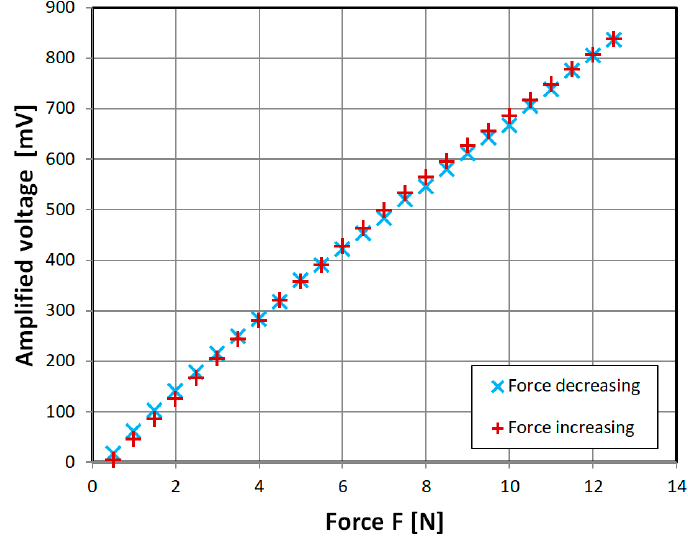
Figure 13. Obtained experimental characteristic of developed ‘diagonal’ sensor. Sinusoidal driving current of 1000 mA, 432 Hz.